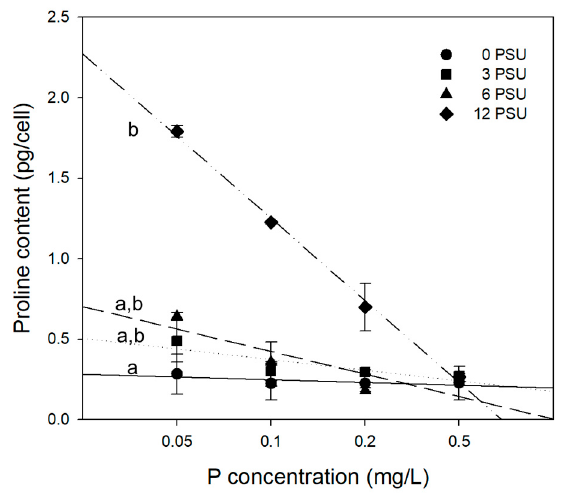
Figure 3. Variation in cellular proline content of S. quadricauda with increasing P concentrations at salinity levels of 0, 3, 6, and 12 psu. Experimental conditions are presented in Table 1 (Exp. 1). Data are presented as averages with standard deviations (bars). Lower case letters on the left side indicate significant di ff erences ( p < 0.05).